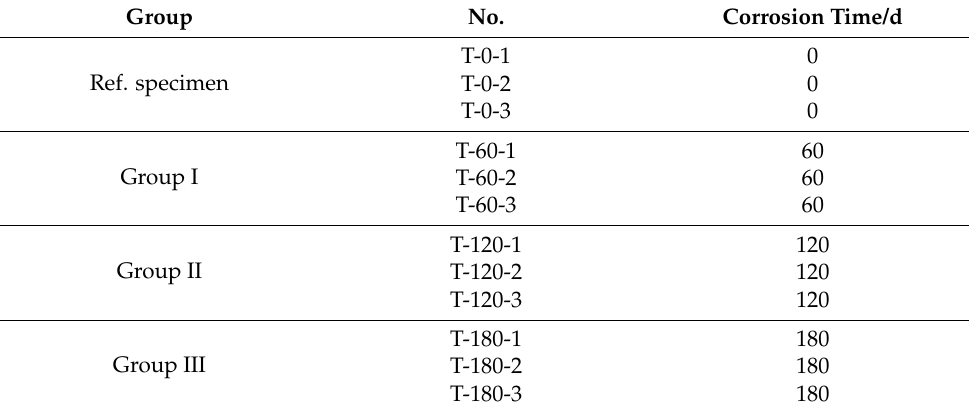
Table 1. Tensile sample grouping.